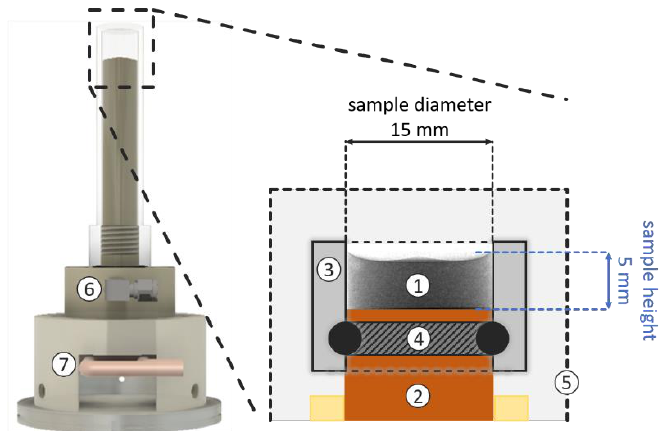
Figure 1. Freeze-drying stage with sample: (1) sample; (2) Peltier element inside cooled copper housing; (3) sample case; (4) rubber seal; (5) capsule; (6) vacuum connection and (7) Peltier element with cooling system (modified illustration from [28]).